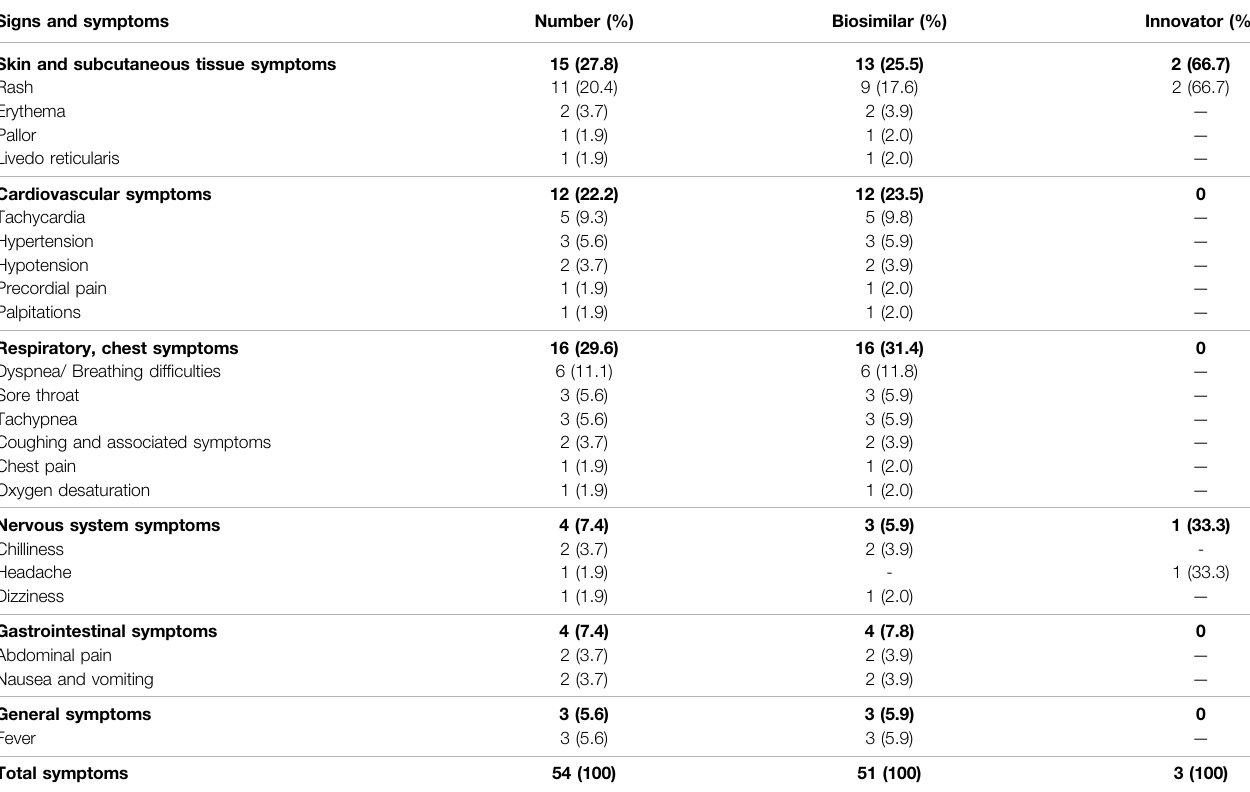
TABLE 5 | Infusion-related reactions to rituximab: signs and symptoms by affected organ system. Signs and symptoms Number (%) Skin and subcutaneous tissue